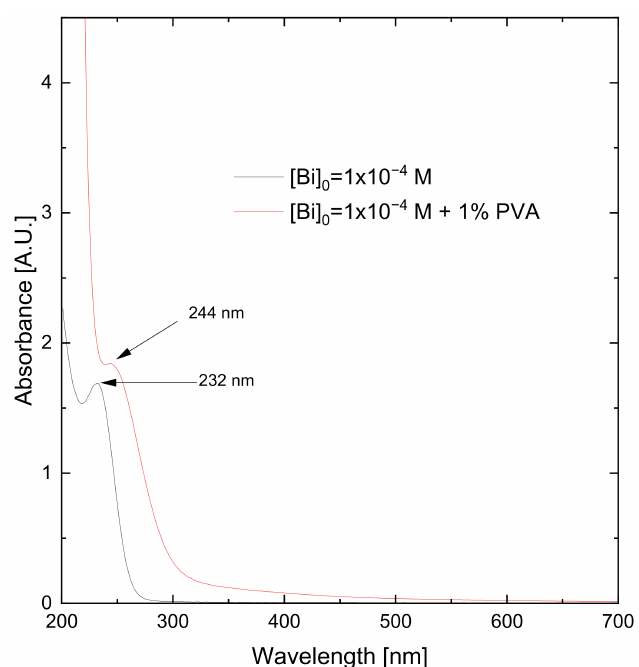
Figure 1. UV–Vis spectra of solutions of synthesized bismuth nanoparticles in the presence and absence of a stabilizer (PVA), at a bismuth concentration of 1 × 10 − 4